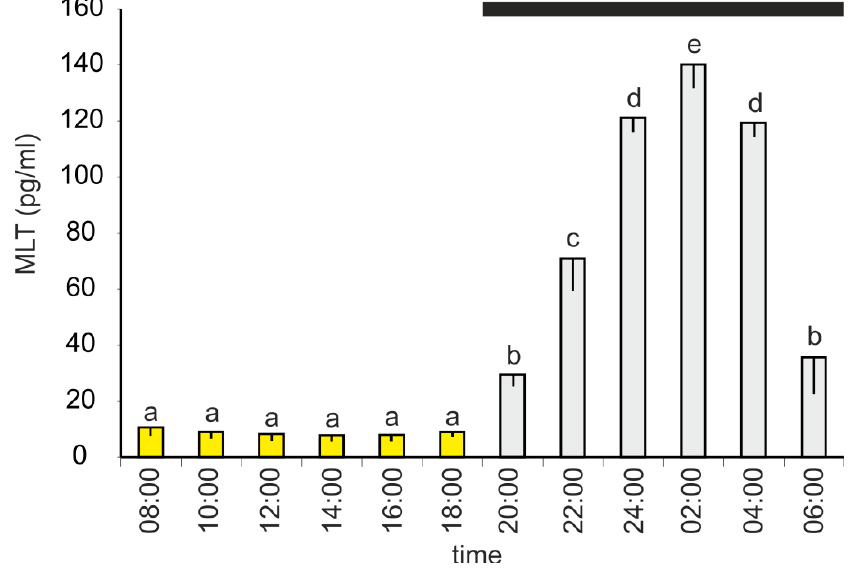
Figure 1. Experiment I. Concentration (mean, and standard error of the mean, SEM) of melatonin in plasma of 10-week-old turkeys kept under a 12L:12D cycle. Values flagged with different letters are significantly different. Black horizontal bar: period of darkness.